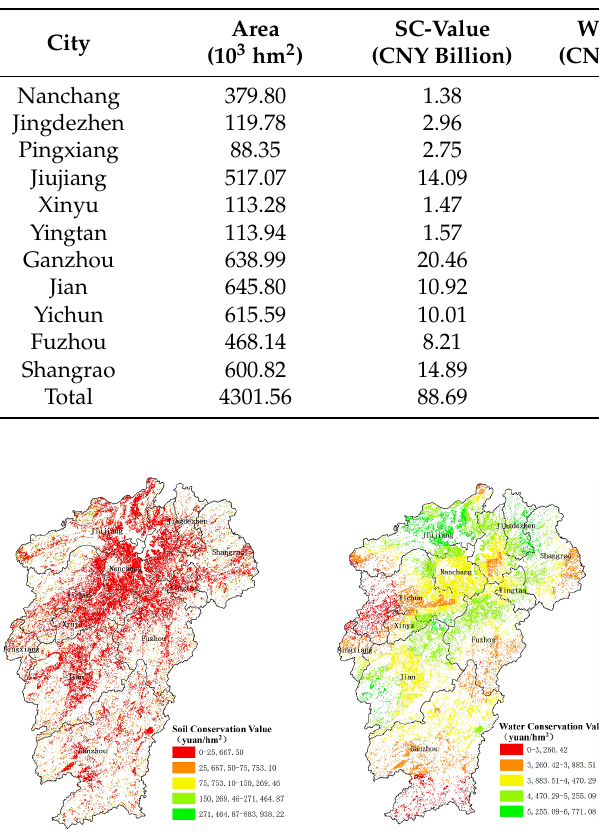
Table 2. The value of cultivated land resource assets by ecosystem service function.